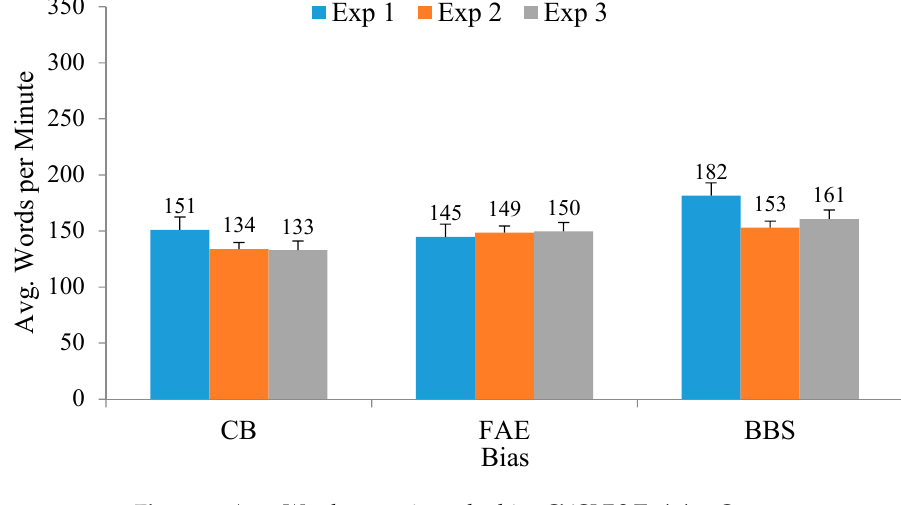
Figure 8. Avg. Words per minute by bias CYCLES Training Center .